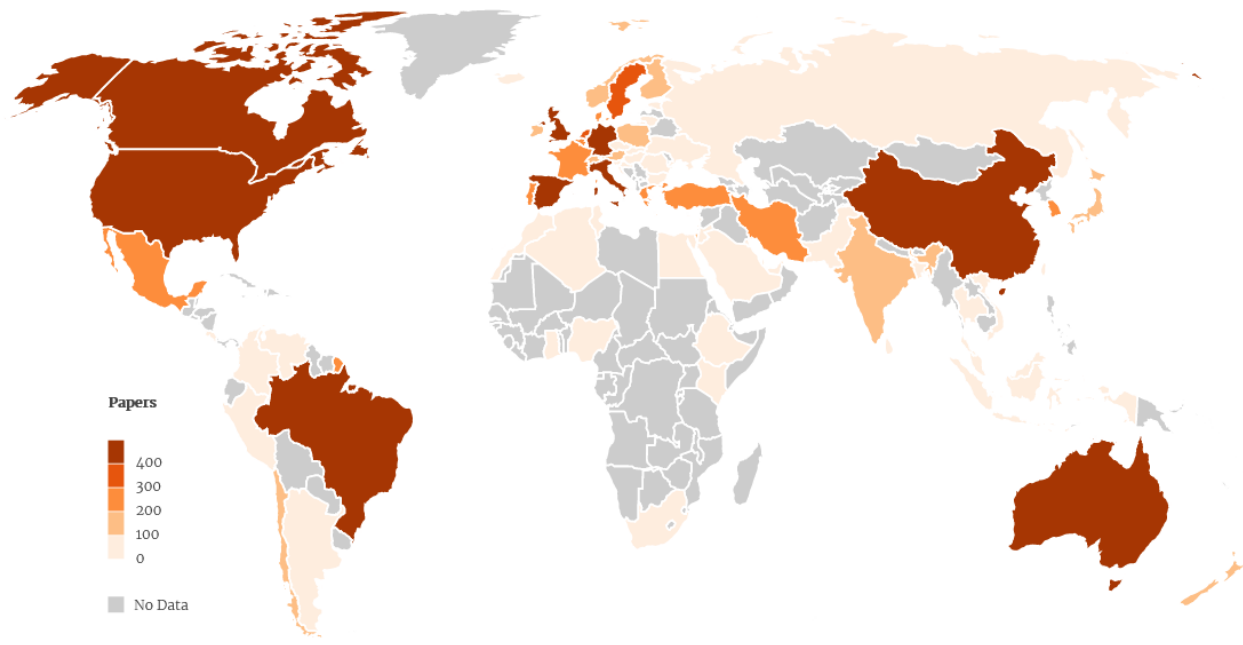
Figure 3. World map of collaboration between countries Figure 2. World map of the published papers by country (>10 papers).